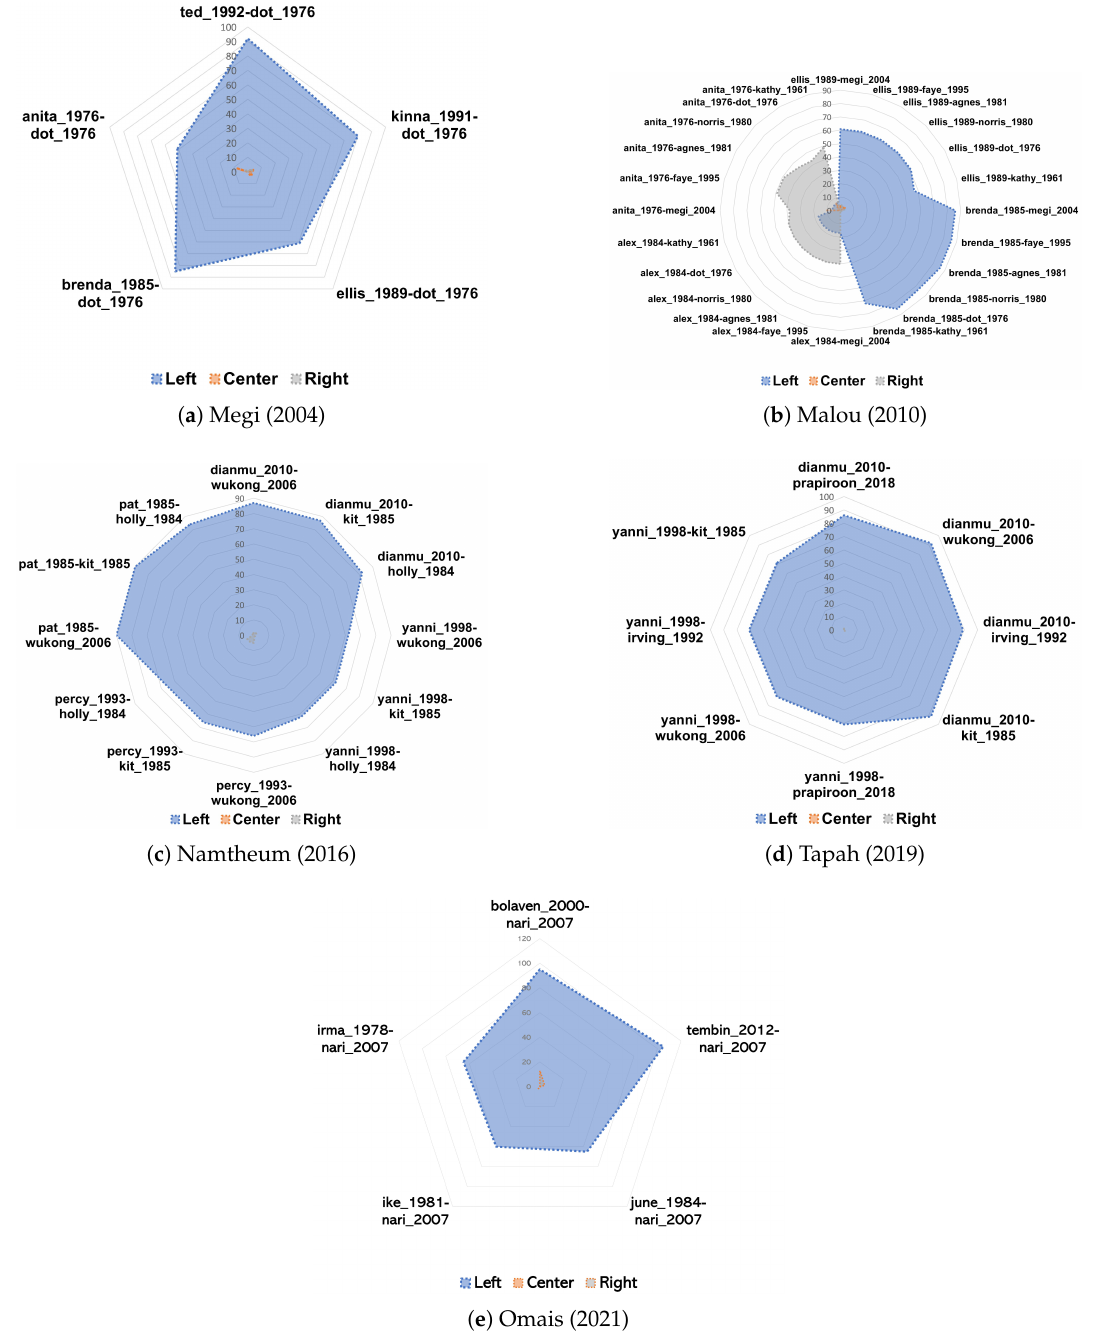
Figure 7. Results of k-NN classification for zonal components: ( a ) Megi 2004, ( b ) Malou